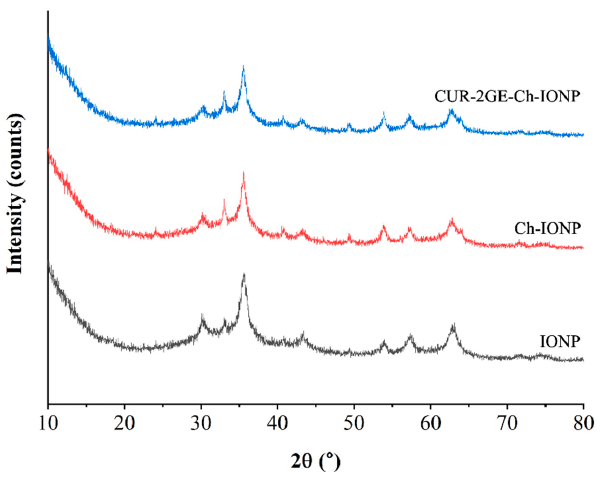
Figure 7. XRD patterns showing the characteristic crystalline nature of the core IONPs in the Ch- IONPs and